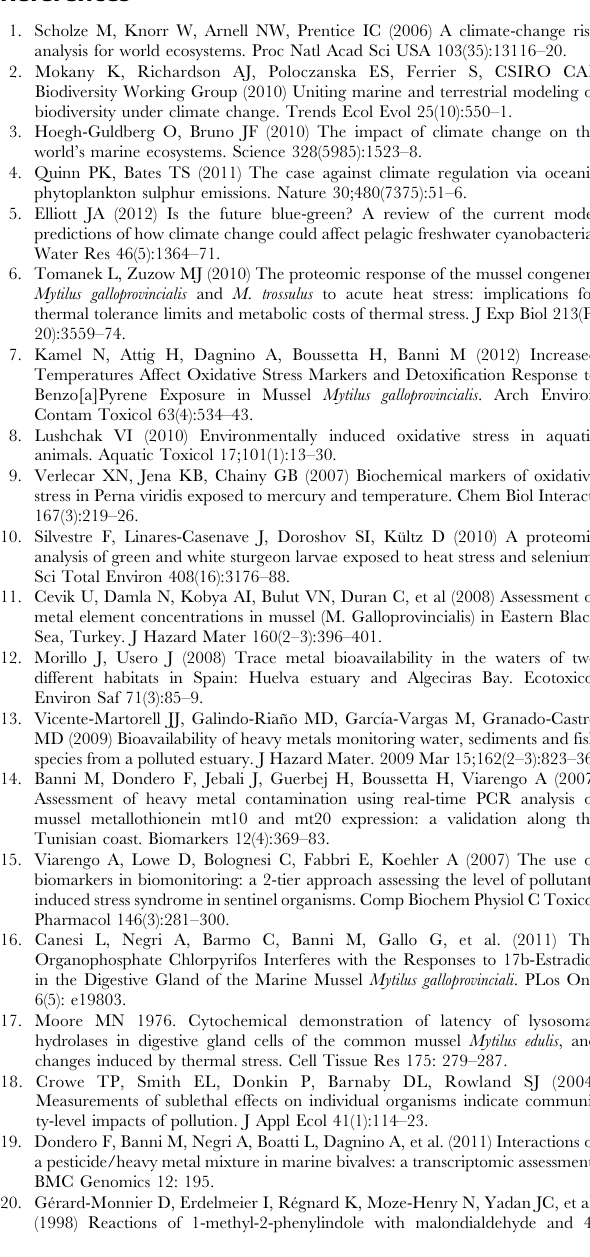
Table S4 Details about the number, the unique ID and their M values in the two conditions (20 6 C and 24 6 C) associated to each cluster (Additional information to